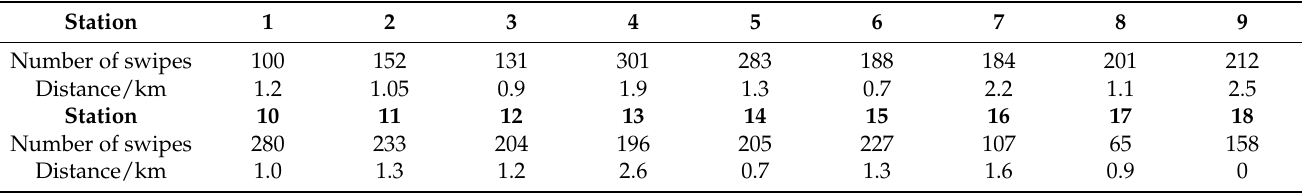
Table A4. Basic data of a bus line in City A.